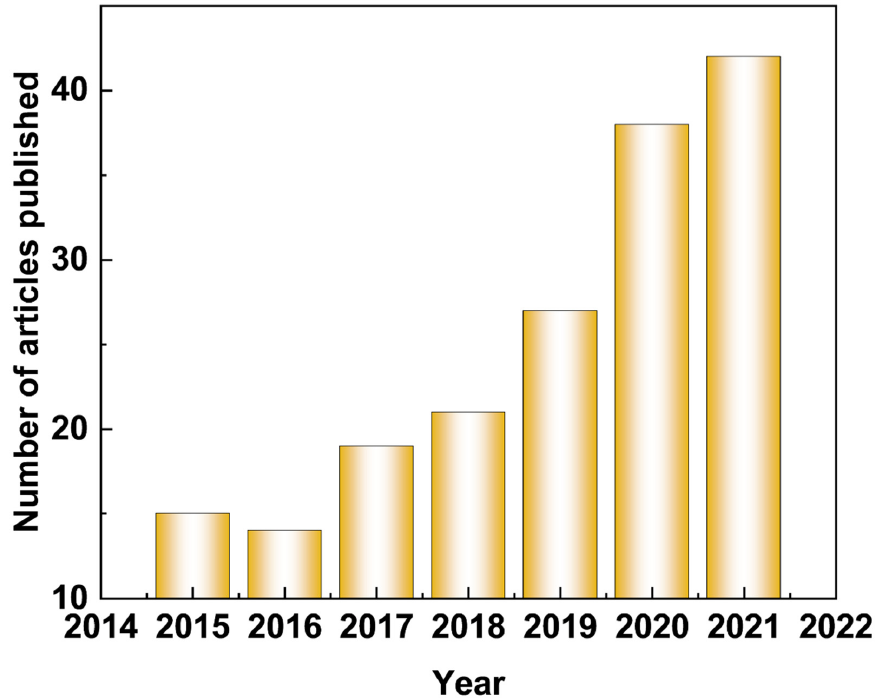
Figure 2. Statistical publications indexed in the web of science by using the term “Self- healing/repairing” and “Magnesium alloy”. The number of publications from 2015 to